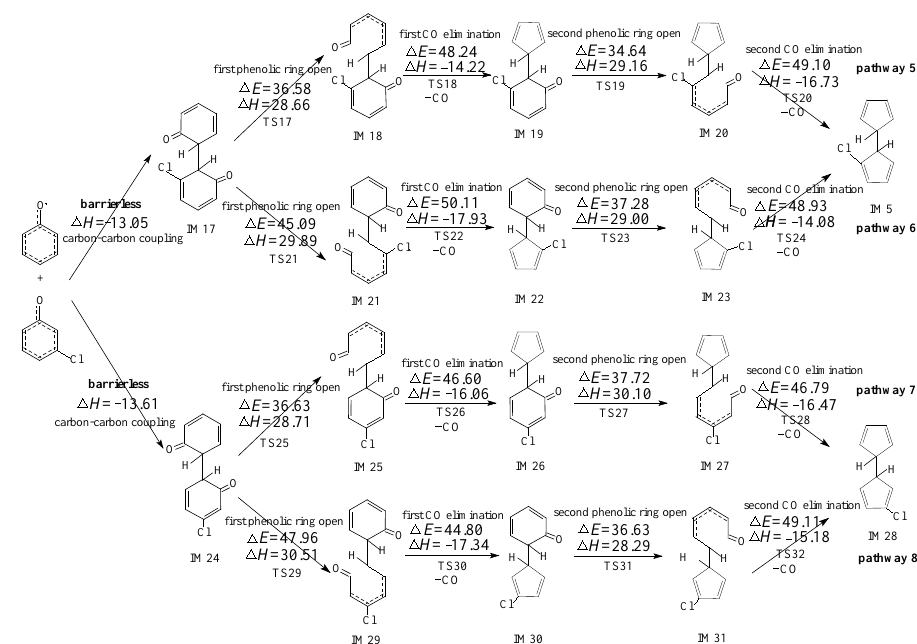
Figure 1. Chlorinated bicyclopentadienyl formation routes embedded with the potential barriers Δ E (in kcal/mol ) and reaction heats Δ H (in kcal/mol) from the dimerization of PhR and 2 − CPR . Δ H is calculated at 0 K.